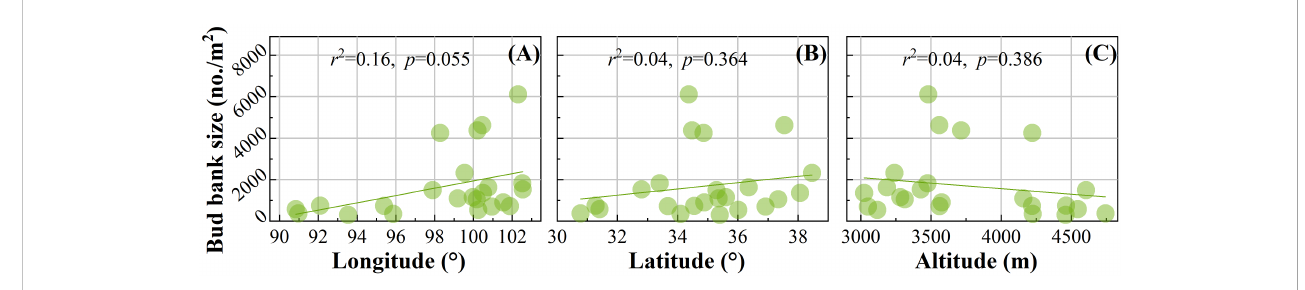
FIGURE 3 Spatial pattern of belowground bud bank. The relationships between BBB and (A) longitude, (B) latitude, and (C) altitude.